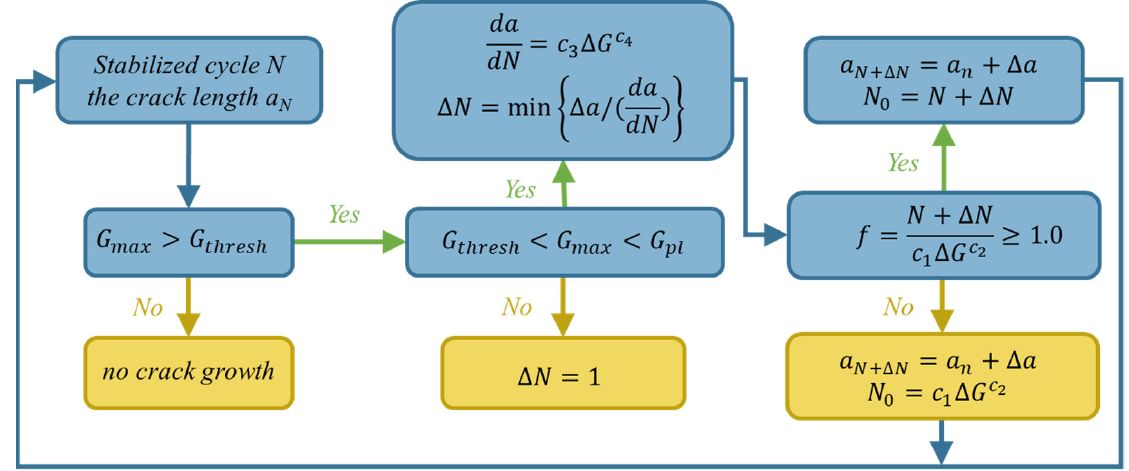
Figure 7. Schematic flow of the computation scheme.